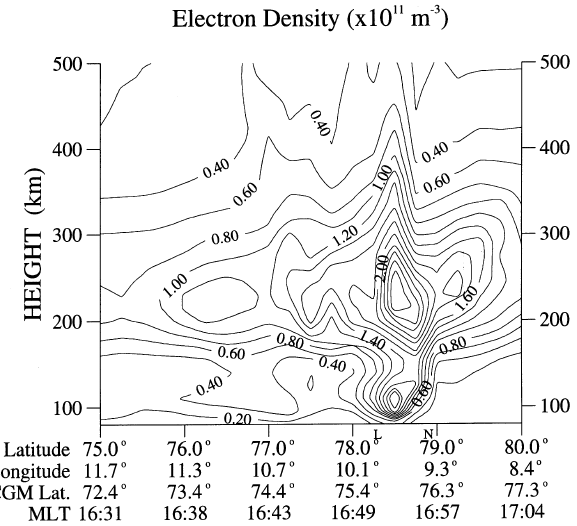
Fig. 4. Tomographic image of electron density for a satellite pass at 13:48 UT on 10 December 1996. The latitudes of Longyearbyen and Ny A˚ lesund are denoted by the letters L and